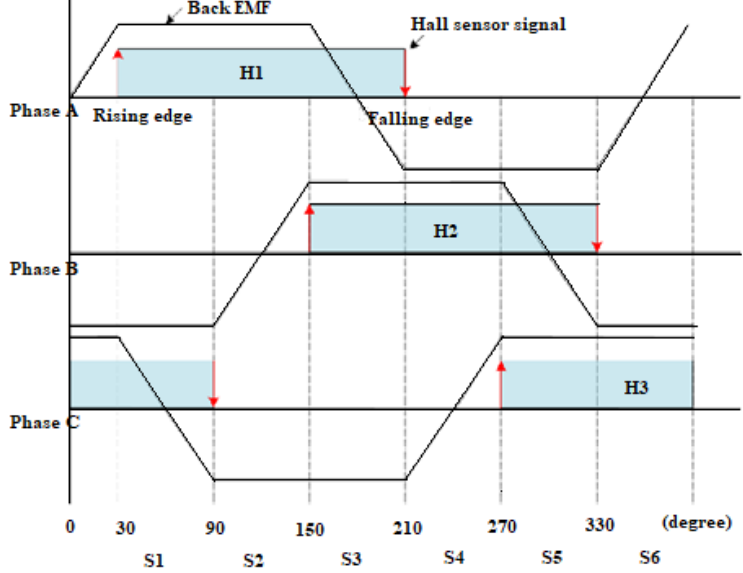
Figure 3. Control signal and back EMF (electromotive force) of brushless direct-current (BLDC) motor.